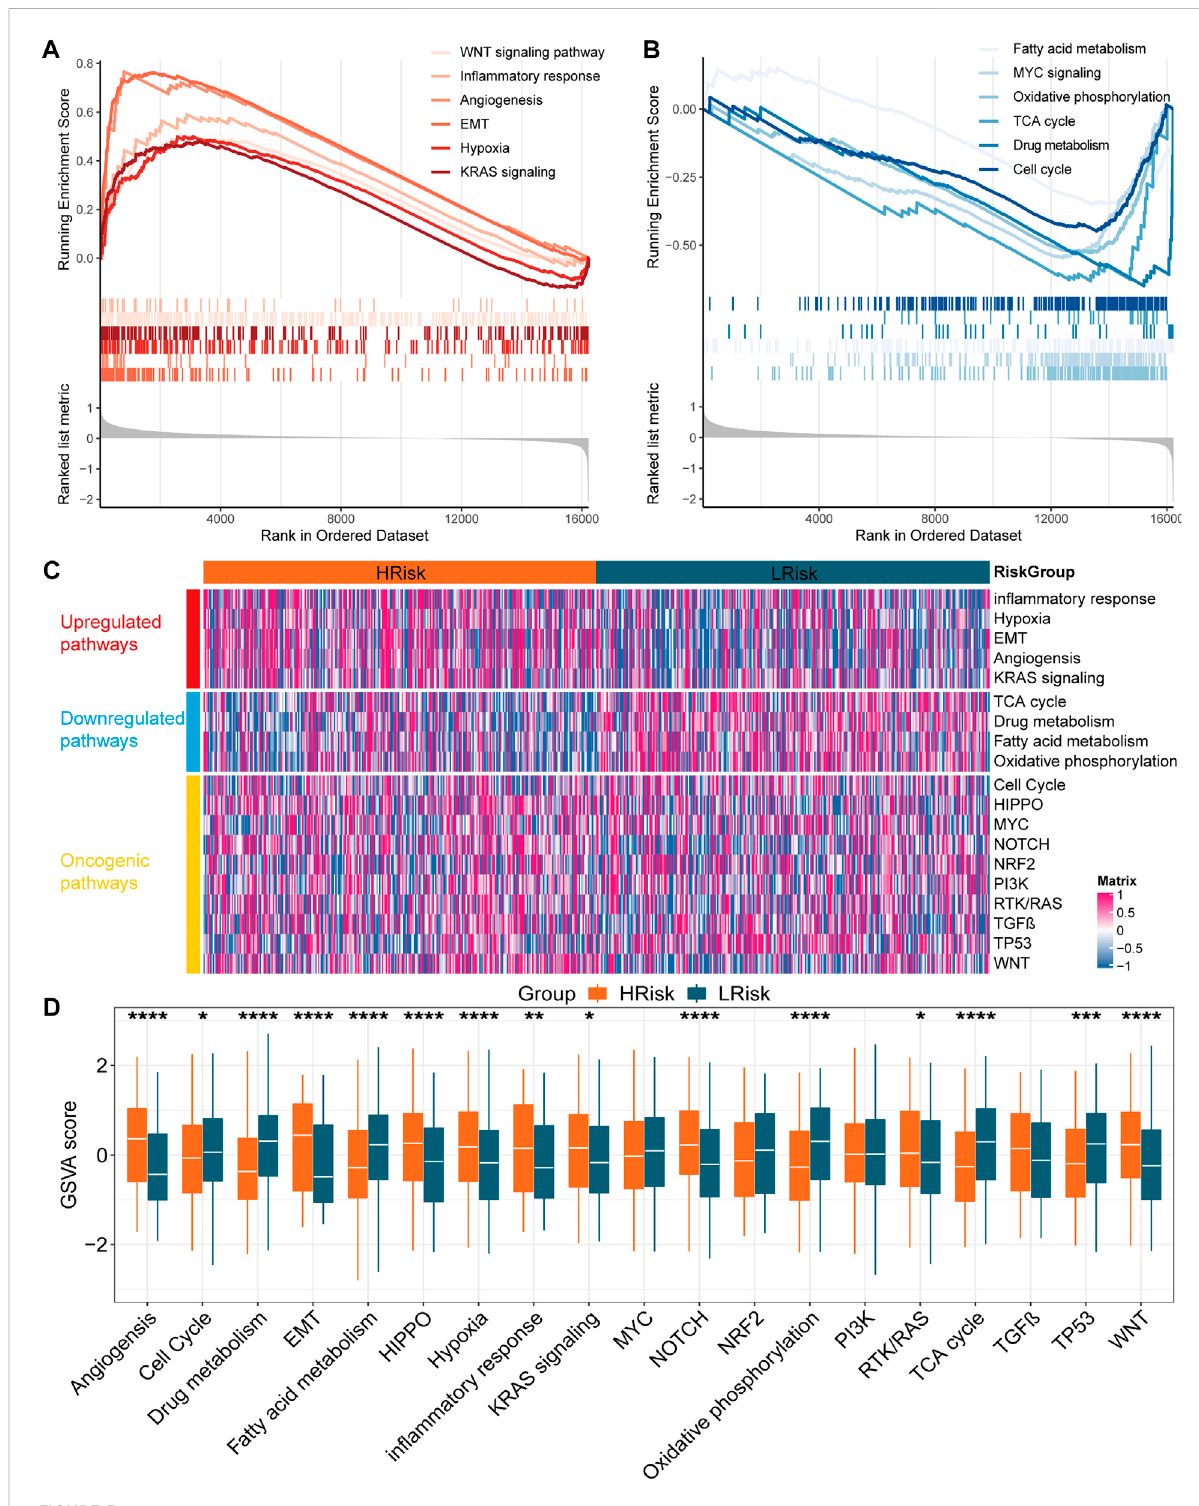
FIGURE 5 Function enrichment analysis in the TCGA cohort (A,B) Gene set enrichment analysis based on GO, KEGG, Hallmark and Reactome. (C) Heatmap for the GSVA score of upregulated, downregulated and oncogenic pathways (D) Boxplot for the GSVA score of upregulated, downregulatedandoncogenicpathwaysbetweentwosubgroups.The p valueswerecalculatedbyWilcoxontest(* p < 0.05;** p < 0.01;*** p < 0.001; **** p <